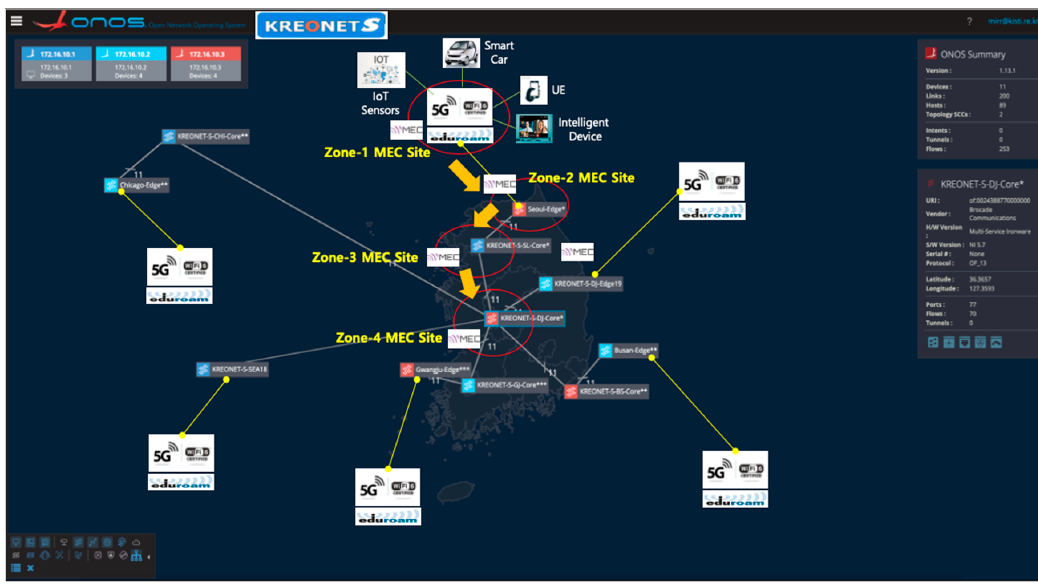
Figure 4. MEC service model integrated with the KREONET-S global network topology.